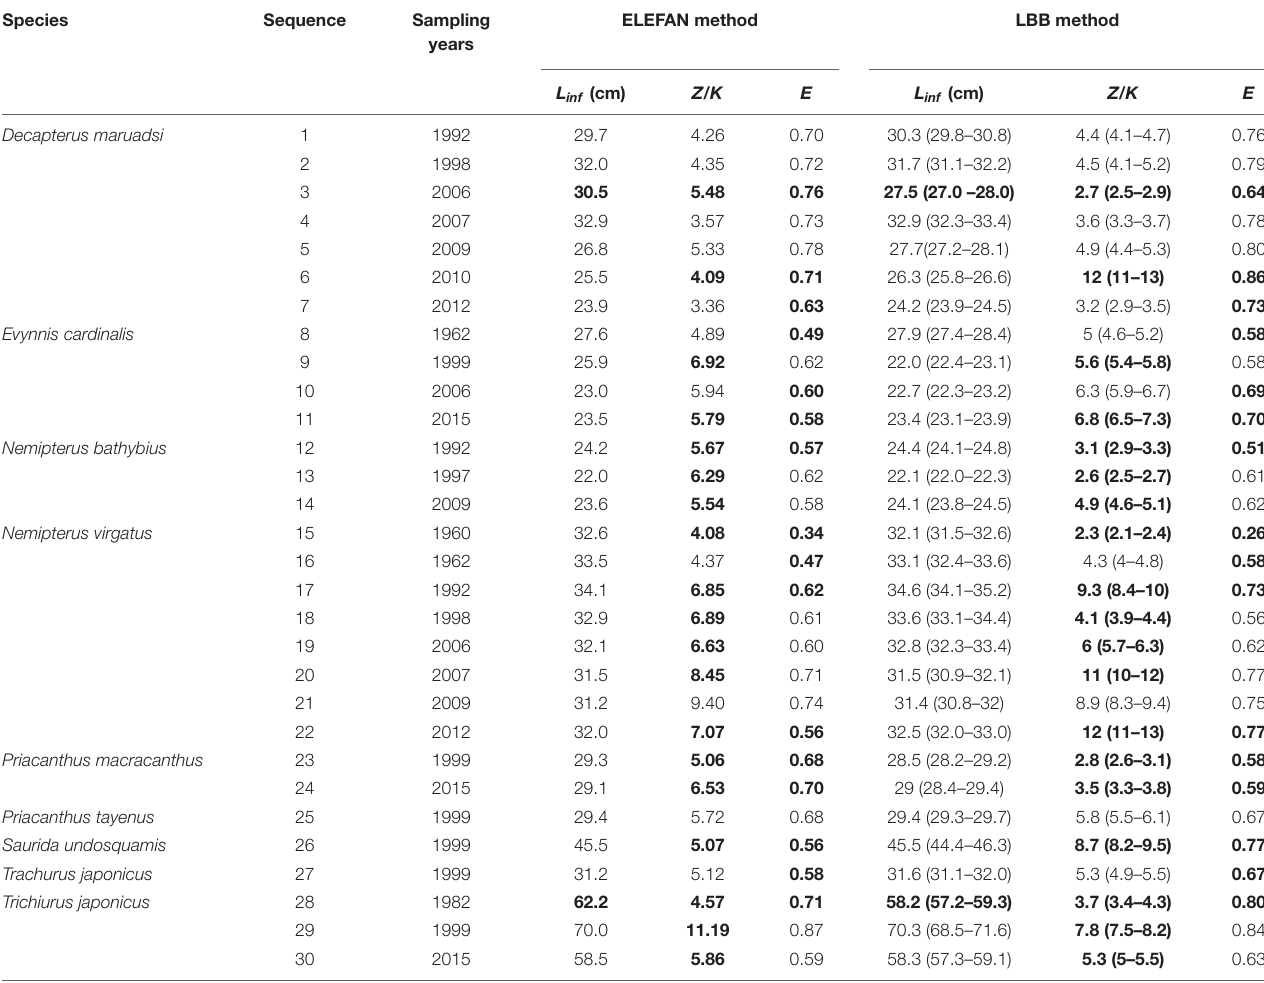
TABLE 2 | Comparison of estimated parameters between ELEFAN method and LBB method with prior information. Species